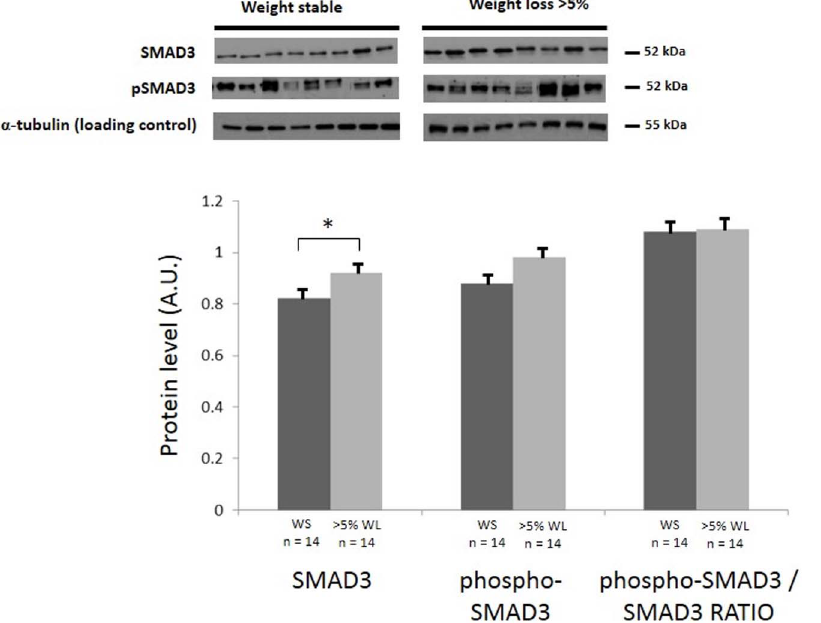
Figure 4. Total SMAD3, phospho-SMAD3 and ratio of phospho-SMAD3/SMAD3 in patients with or without . 5% WL (Group I) levels. Western blot analysis with indicated antibodies, a -tubulin was used as a loading control. Graph shows the mean ( 6 SEM) protein level represented in arbitrary units (A.U). (*, P , 0.05 by Student’s t test).